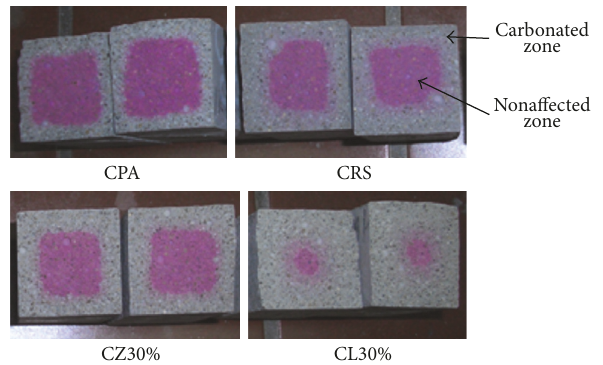
Figure 2: Continuous air cure for one year.